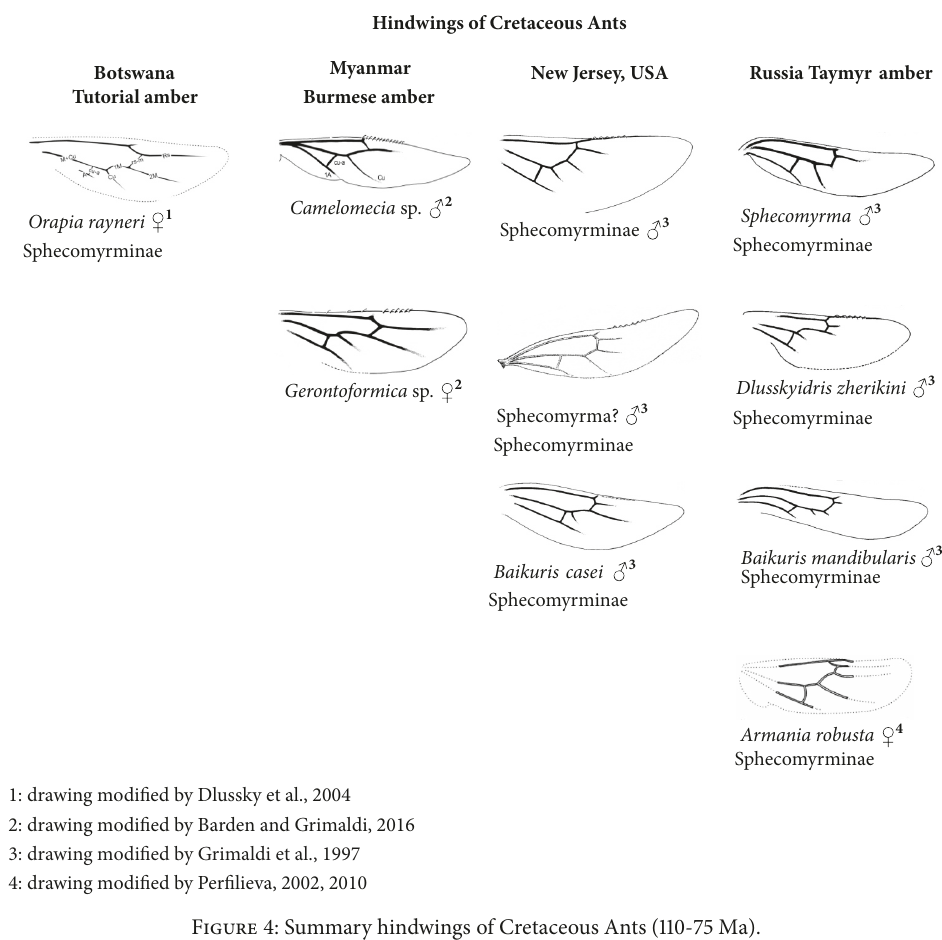
Figure 4: Summary hindwings of Cretaceous Ants (110-75 Ma).